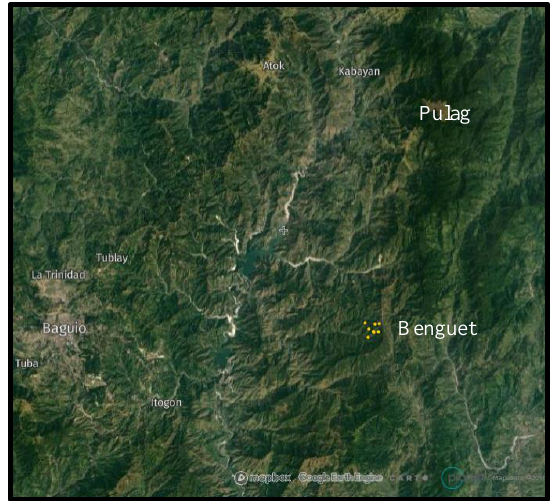
Figure 1 . Detected fires (yellow pixels) on April 24-26, 2021 from VIIRS in Benguet, Philippines